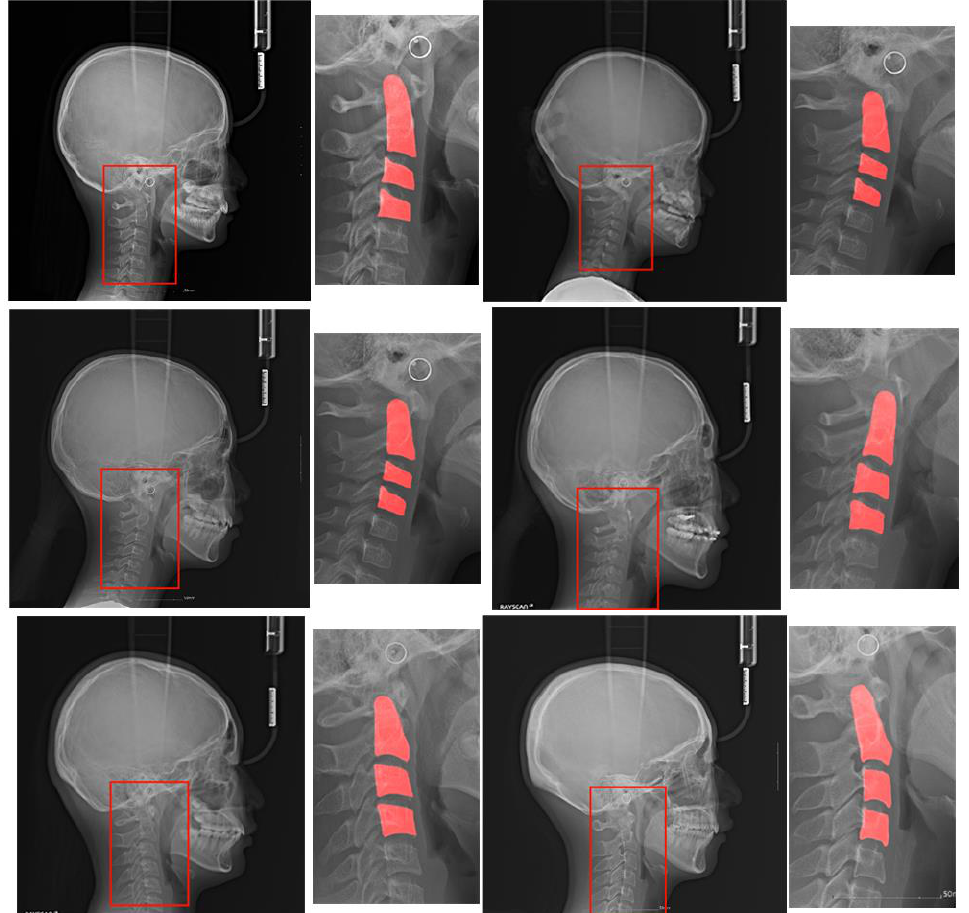
Figure 1. Original lateral cephalograms and regions of interest (ROIs) with segmentation regions. These pairs are examples of each of the six stages of a lateral cephalogram, and each pair has an original image and ROI with the C2, C3, and C4 segmentation regions. The red box in the original image is the ROI and it is magnified on the right side with the segmentation region. Note that cropped images have various sizes.